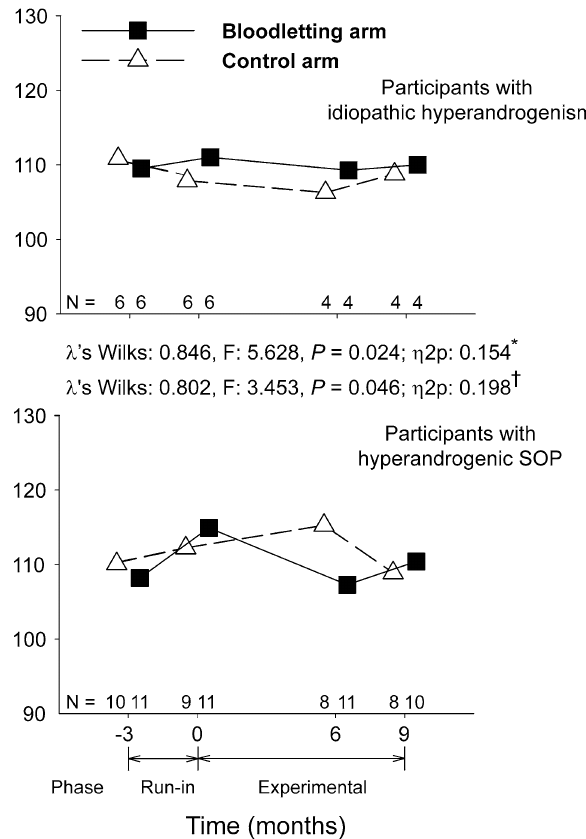
Figure 3. Influence of functional hyperandrogenism (hyperandrogenic PCOS vs idiopathic hyperandrogenism) on systolic blood pressure. Data are shown as means (SEM) of the patients remaining at each visit of the trial (figures above the x-axis) even though we conducted intention-to-treat statistical analyses. *Interaction with the visit of the study during the run-in period. †Interaction with the visit of the study and arm of treatment during the experimental phase of the